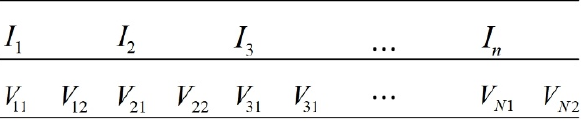
Figure 6. Location representation of the Michigan method rule.